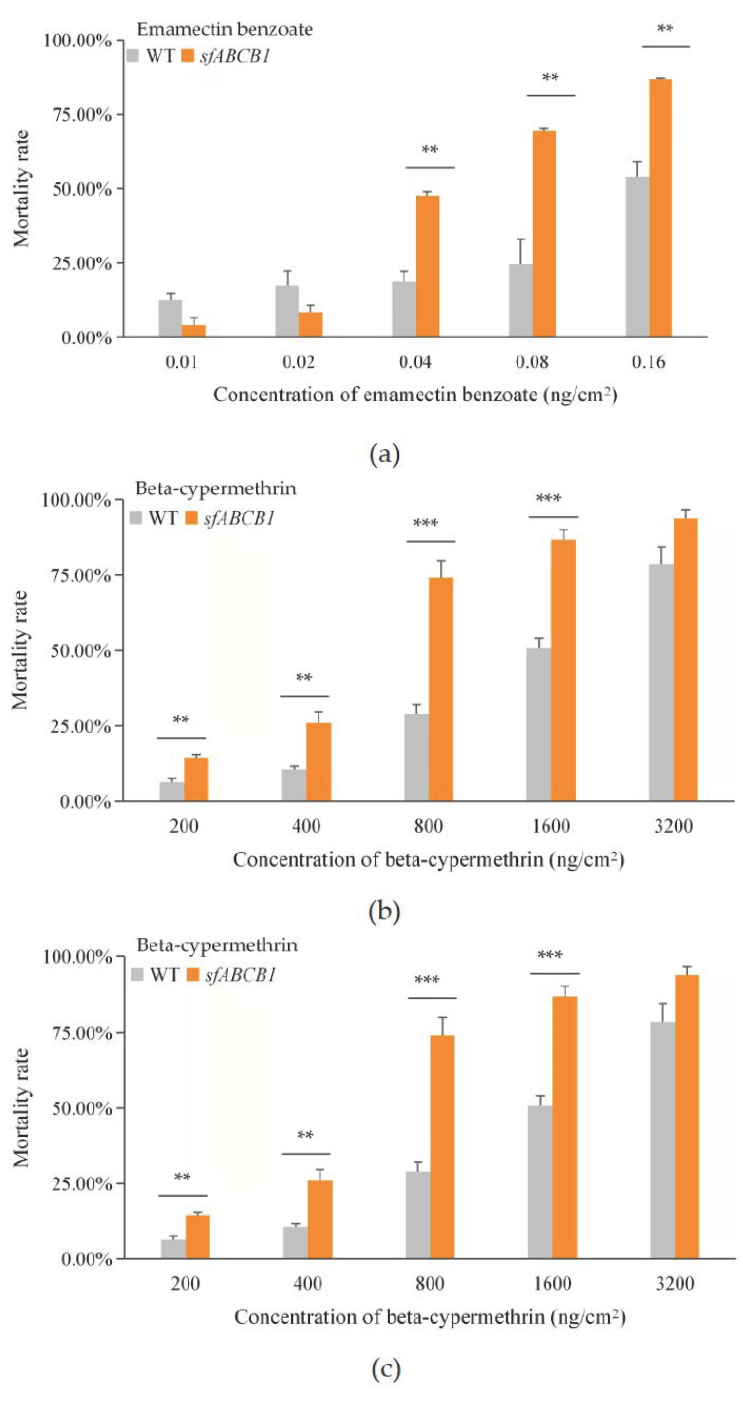
Figure 3. Mortality rate of DH19wild type and sfABCB1 strains at different concentrations of ( a ) emamectin benzoate; ( b ) beta-cypermethrin and ( c ) chlorantraniliprole. *, p < 0.05; **, p < 0.01; ***, p <